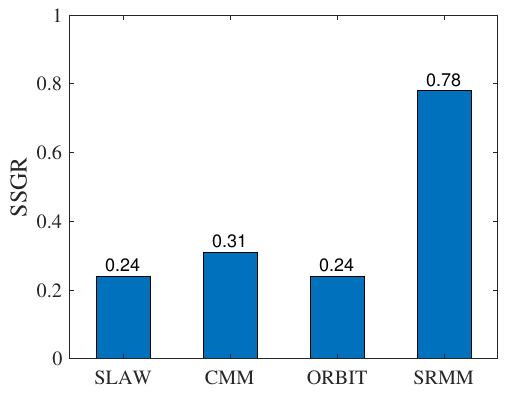
Figure 11. The same social group ratio values from various models with the real road